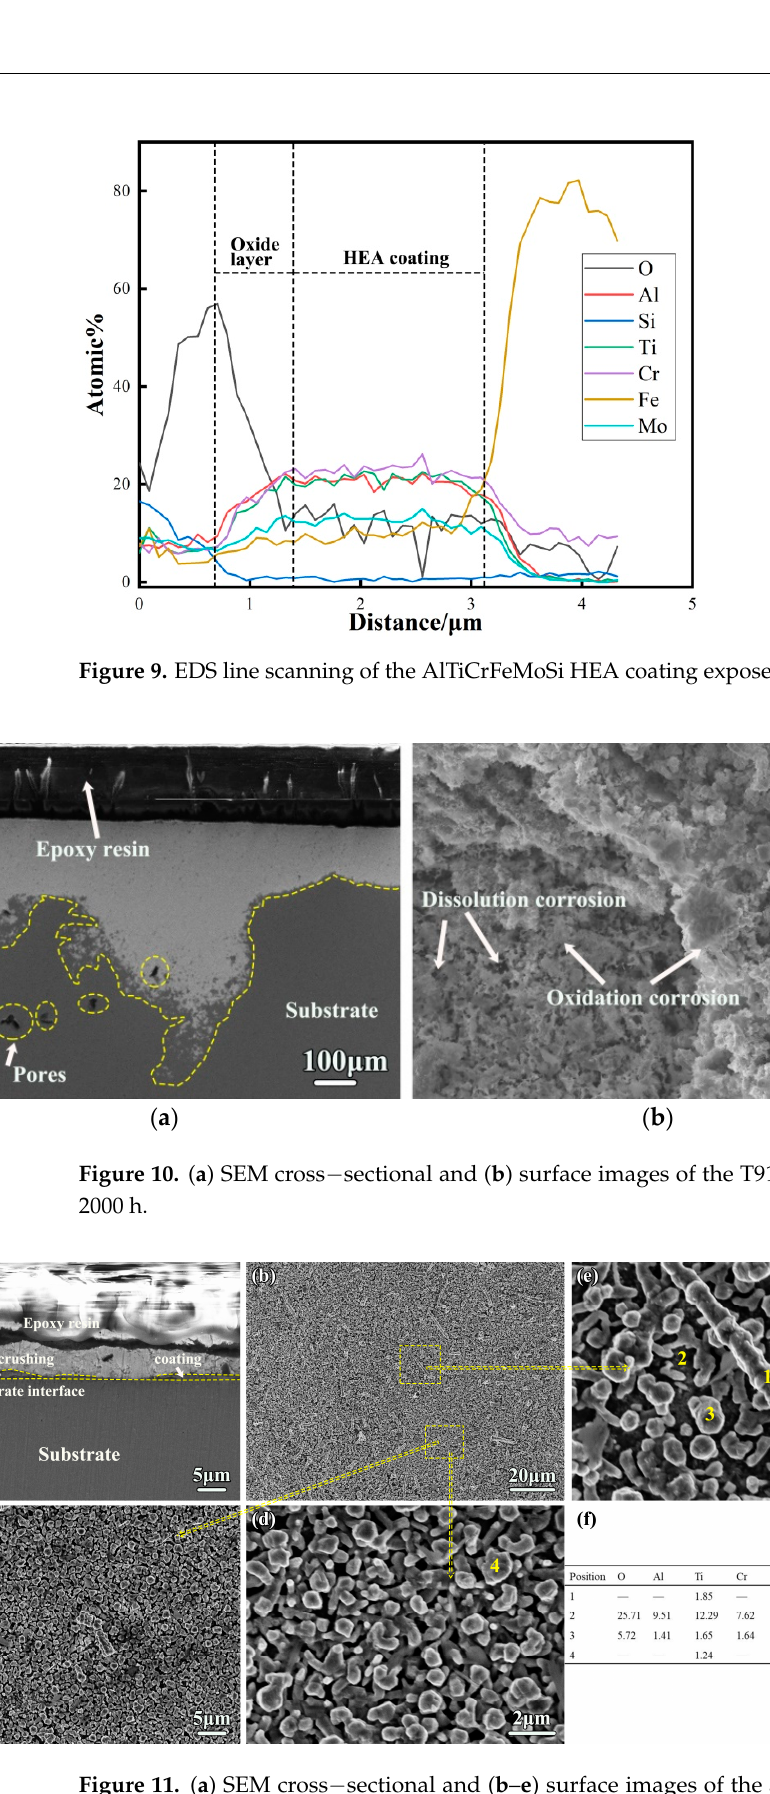
Figure 8. ( a – c ) SEM surface and ( d , e ) cross sectional images of the as − deposited AlTiCrFeMoSi